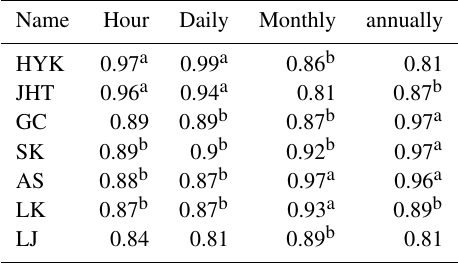
Table 4. Hurst value of sediment.